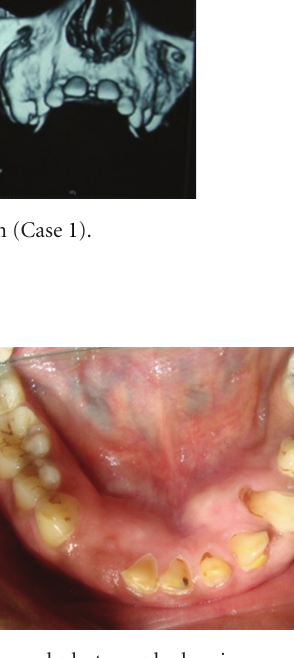
Figure 11: Intraoral photograph showing mandibular arch (Case 2).